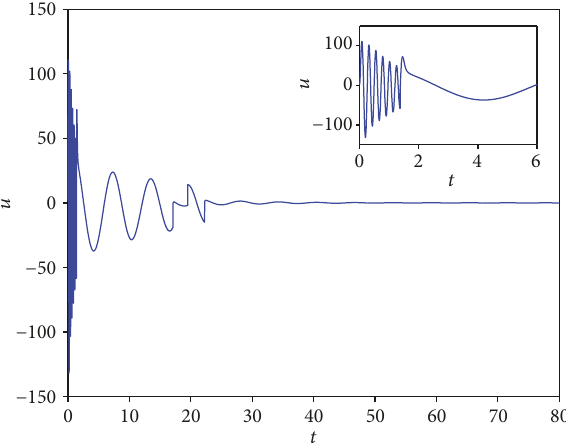
Figure 5: Time response of the control input for